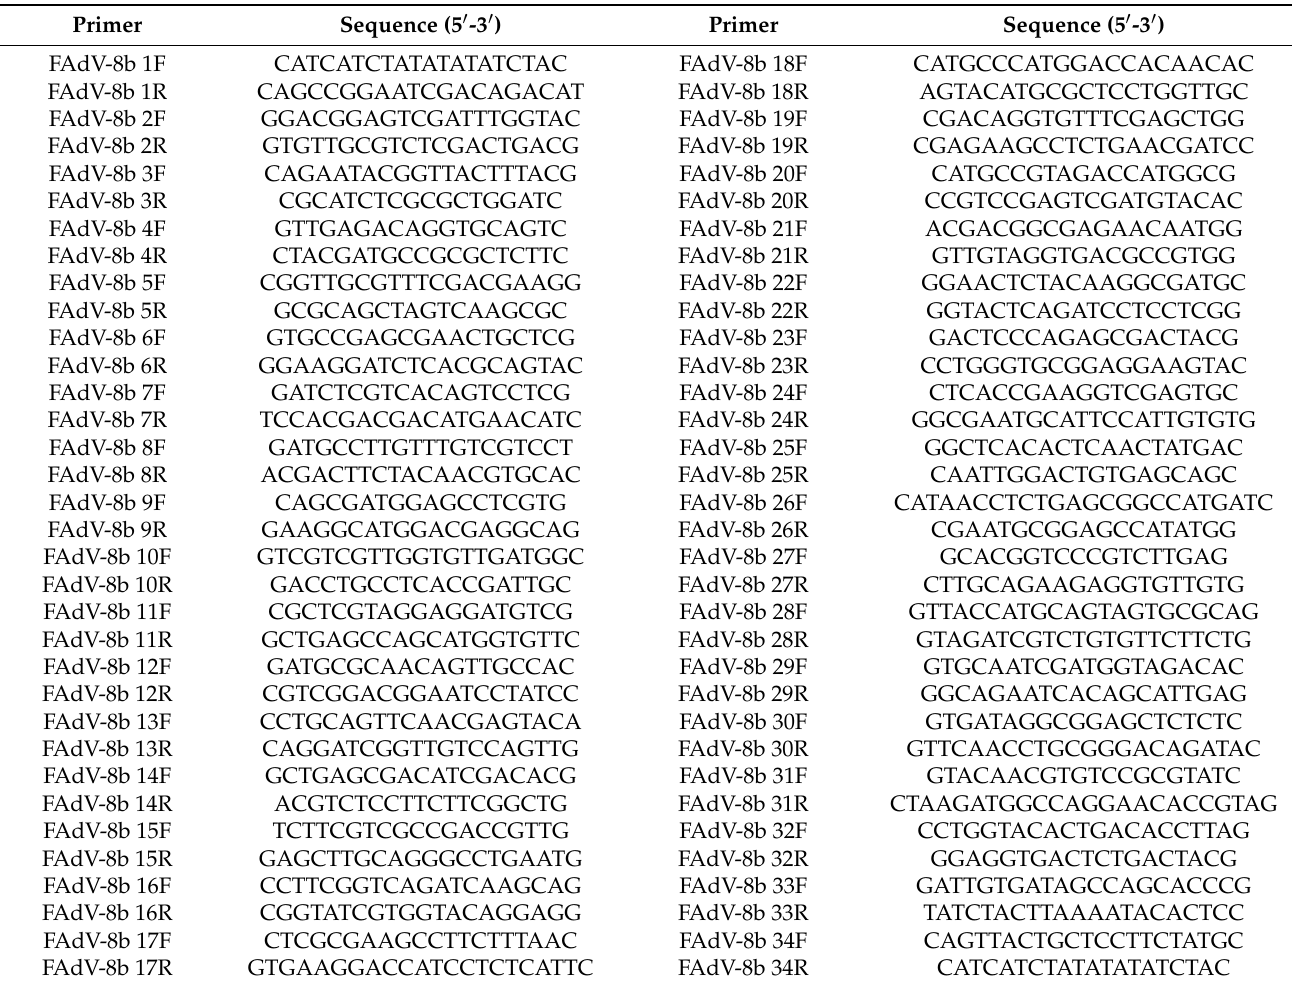
Table 1. The primers for complete genome sequencing of